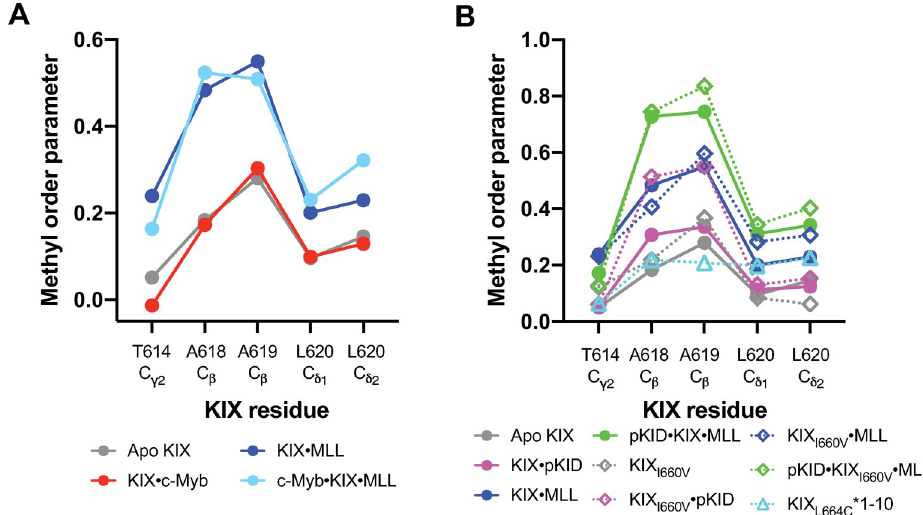
Fig 8. Methyl order parameters of the L 12 -G 2 loop by residue. (A) Order parameters for (A) the c-Myb system and (B) the pKID system. Solid lines represent the wild type system, whereas dashed lines correspond to the allosteric modulators (I660V mutation and molecule